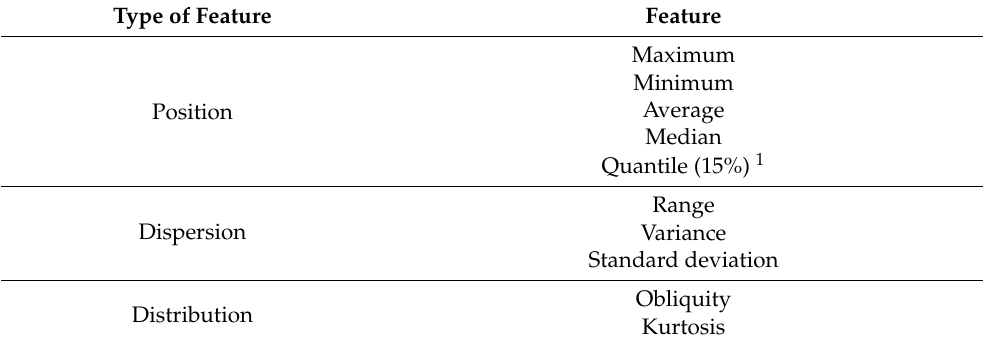
Table 3. Evaluated